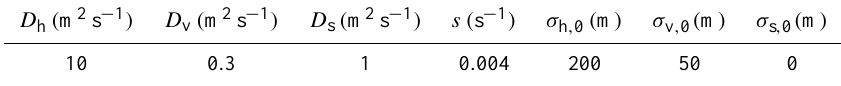
Table 1. Diffusion parameters obtained from in situ measurements (Schumann et al.,